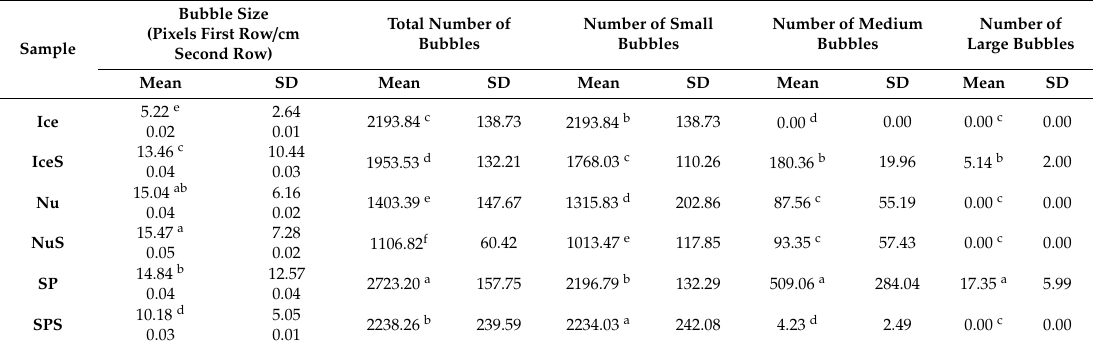
Table 4. Means and standard deviation (SD) of bubbles analysis. Di ff erent letters denote significant di ff erences between samples assessed using the Fishers least significant di ff erence test with α = 0.05.